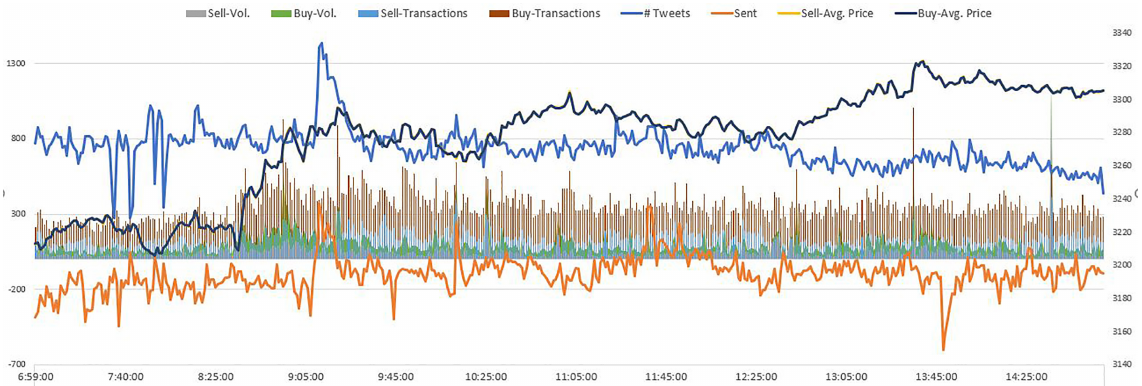
Figure 4. Graphical representation of data related to cryptocurrency Ethereum (ETH). Source: com- piled by